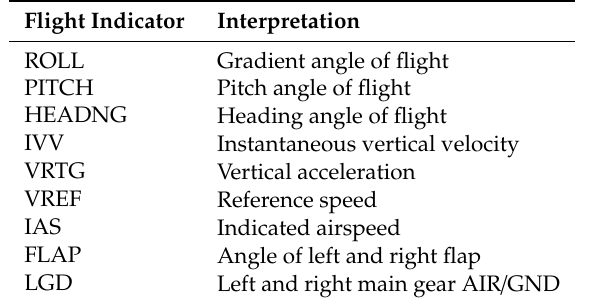
Table 1. Interpretations of flight parameters in the quick access recorder (QAR) data.